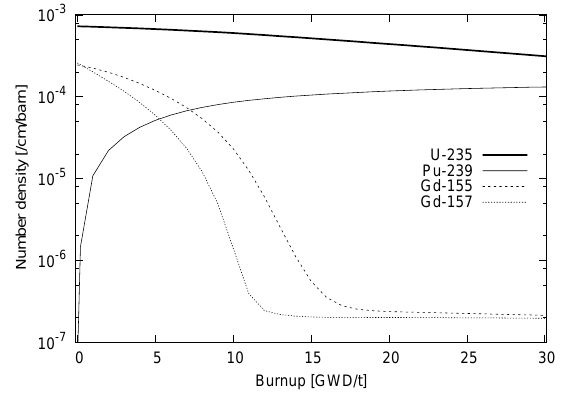
Figure 3. Volume-averaged nuclide number densities in the Gd- bearing rod